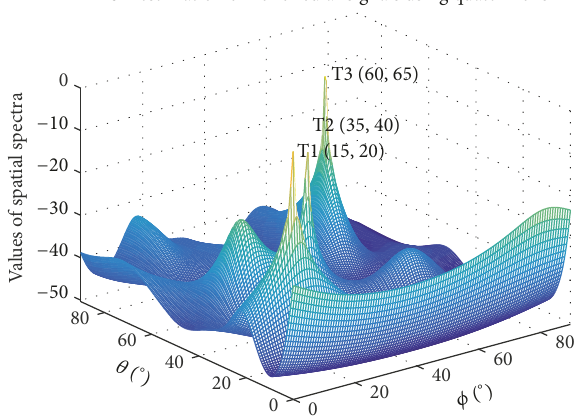
Figure 2: The spatial spectra of noncircular